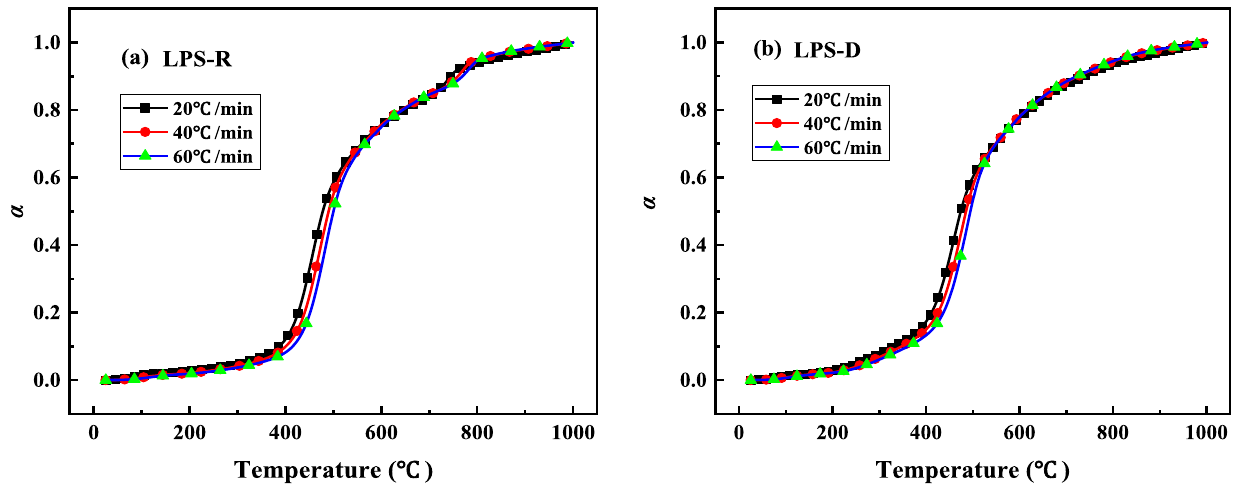
Fig. 8 Pyrolysis conversion curve of LPS-R and LPS-D with temperature at different heating rates